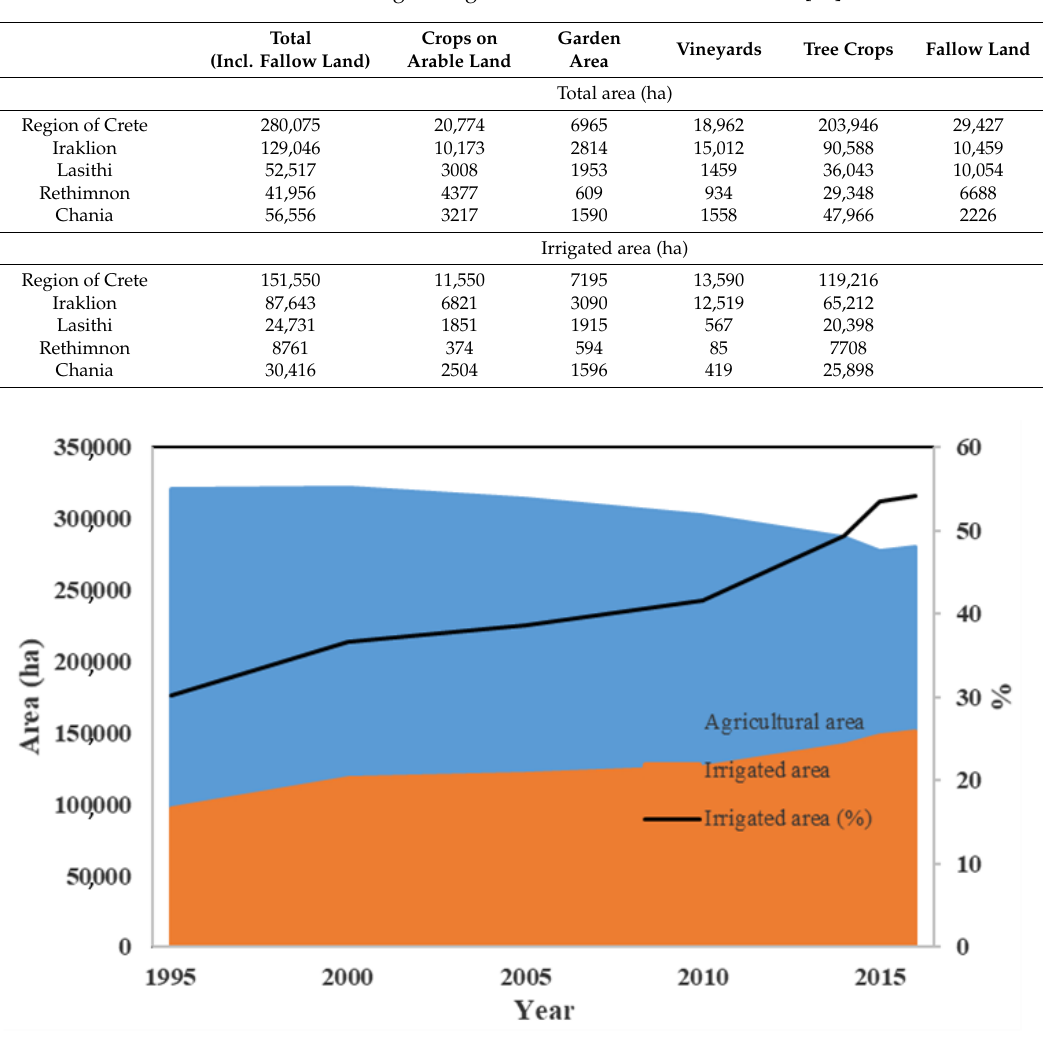
Table 6. Total and irrigated agricultural areas of Crete. Source: [65].